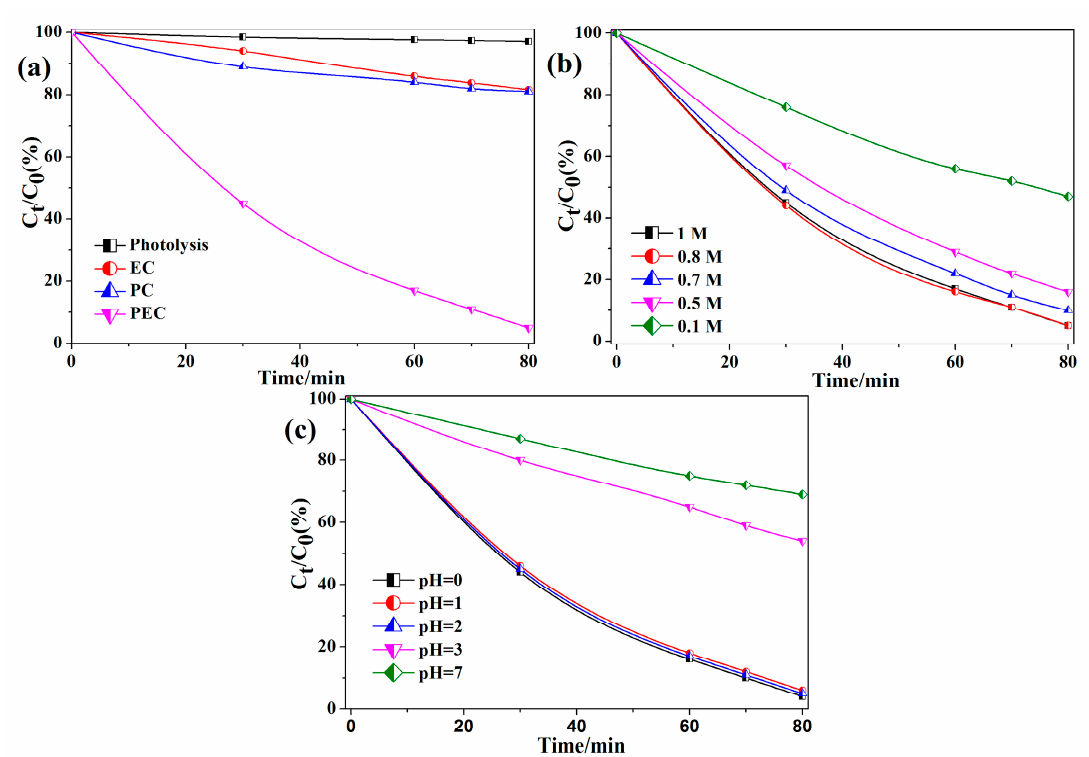
Figure 2. ( a ) The degradation of 5 mg/L methyl orange (MO) within 80 min by photolysis, photocatalysis, and PEC in 1 M Na 2 SO 4 medium at pH = 2, respectively. ( b ) Removal of MO in a varying concentration of Na 2 SO 4 aqueous solution (pH = 2) or ( c ) with different pH values (1 M Na 2 SO 4 ). The initial conditions: MO 5 mg L − 1 , applied 1.5 V vs. counter electrode (CE).